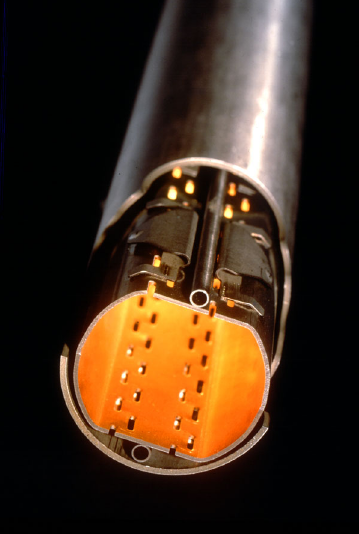
FIG. 1. The LHC slotted copper-plated beam screen and stainless steel cold bore.